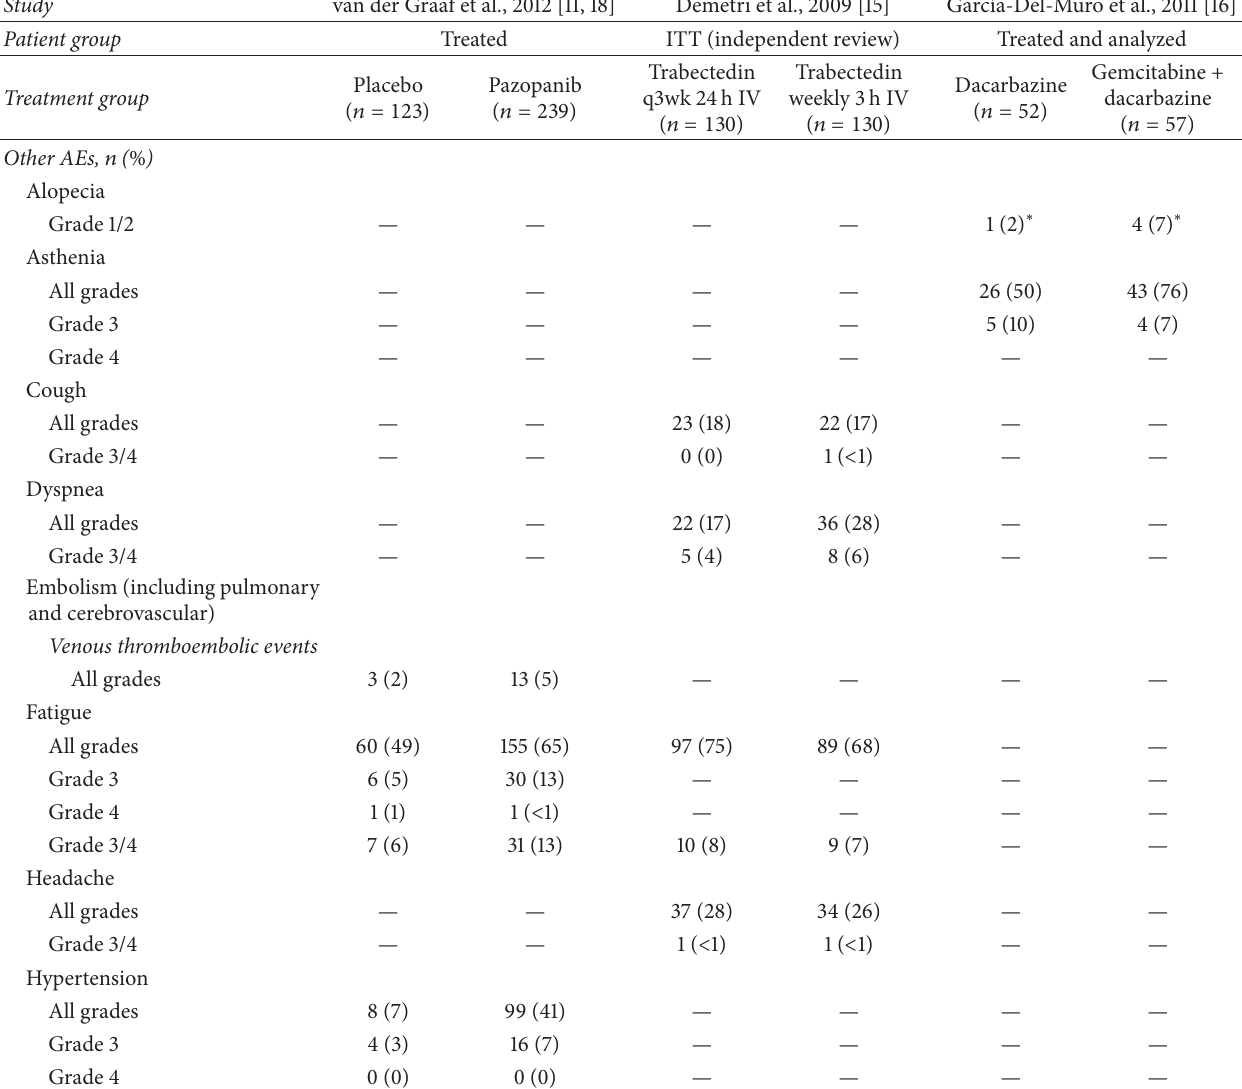
Table 4: Patients experiencing selected other